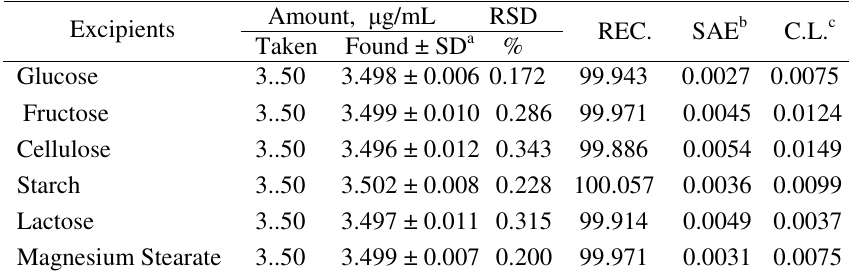
Table 3. Summary of accuracy and precision results of the proposed method after adding excipients.